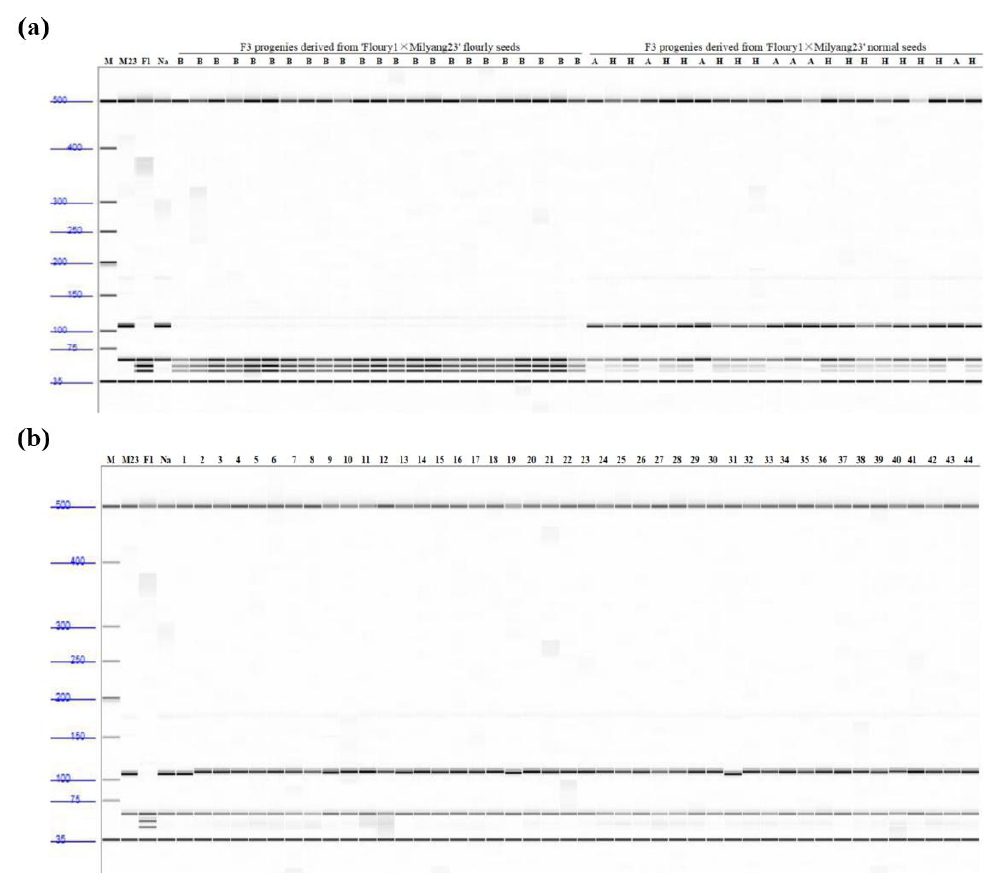
Figure 3. Co-segregation analysis of the flo4-5 genotype with floury endosperm phenotype. ( a ) Verification of the CAPS marker (digestion by MboII ) and tagging the flo4-5 locus using a part of F3 individuals; ( b ) Verification of the CAPS marker (digestion by MboII ) and tagging the flo4-5 locus using Korean rice cultivars. ‘A’ and ‘B’ are homogeneous of Namil(SA)-flo1 and Milyang 23, respectively. ‘H’ is heterozygote. M (100bp ladder), F1 (Namil(SA)-flo1), M23 (Milyang 23), Na (Namil). 1. Namil(SA)-flo2(Suweon542), 2. Aranghyangchal, 3. Baegjinju1, 4. Baekogchal, 5. Boramchal,